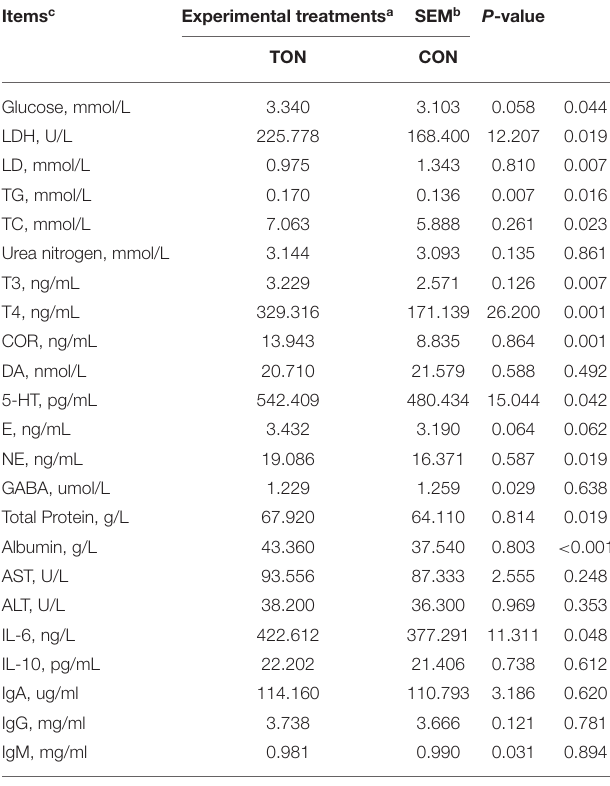
TABLE 4 | Number of observed species, richness and diversity indices in rumen microbes of dairy cow showing tongue- rolling behavior or no signs of abnormal behavior.